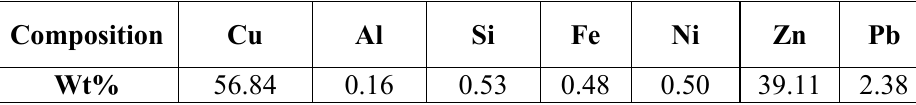
Table 1: Chemical composition of C86400 Cu-Zn